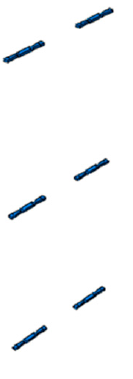
Figure 15. Connector model (side).